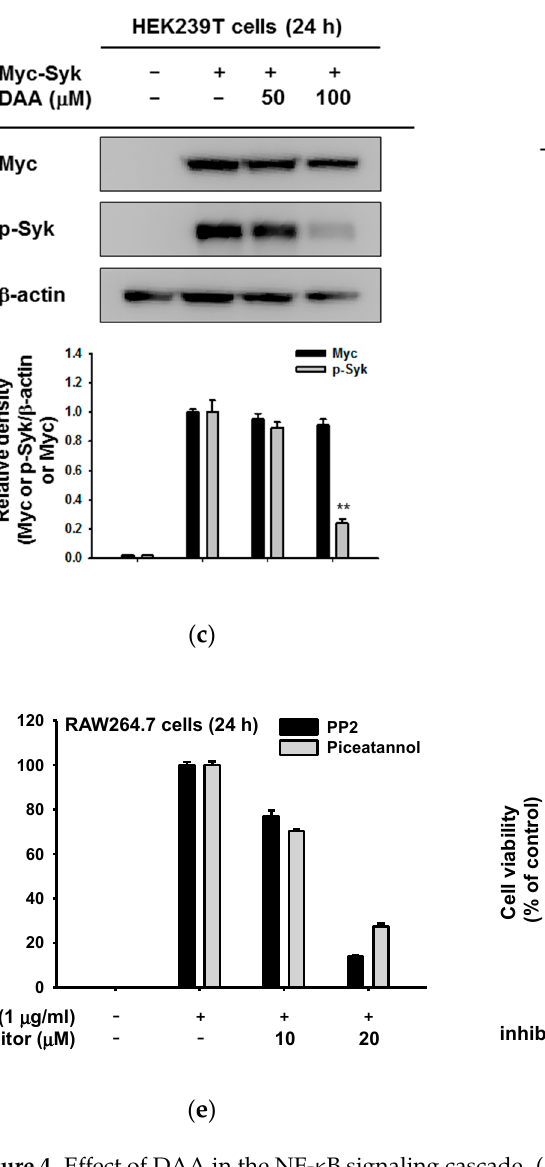
Figure 4. Effect of DAA in the NF- κ B signaling cascade. ( a , b ) RAW264.7 cells were pre-treated with DAA, and LPS was applied in a time-dependent manner. Whole cell lysates were prepared, and immunoblotting was performed. Antibodies against phosphorylated or total I κ B α , IKK α / β (serine 176/180), Src, Syk, and β -actin were used. ( c , d ) Myc-Syk or human influenza hemagglutinin (HA)-Src plasmids were transfected into HEK293T cells for 24 h, and then DAA (0–100 µM) was applied for an additional 24 h. Phosphorylated Syk and Src, Myc, HA, and β -actin were detected in whole cell lysates by immunoblotting. ( e ) (4-amino-5-(4-chlorophenyl)-7-(t-butyl) pyrazolo[3,4-d]pyrimidine) (PP2) or piceatannol (0–20 µM) was pre-treated on RAW264.7 cells for 30 min, and LPS (1 µg/mL) was treated for additional 24 h. NO production was determined by Griess assay. ( f ) Cytotoxicity of PP2 or piceatannol on RAW264.7 cells was examined by MTT assay. WCLs: whole cell lysates. Relative intensity ( b , c ) was the calculated ratio using densitometric scanning values of phospho-proteins and densitometric scanning values of β -actin or total forms of proteins from blots observed with independent repeats ( n = 3) by the DNR Bio-imaging system (Gelquant software Version 2.7). * p < 0.05 and ** p < 0.01 compared to the induced group.